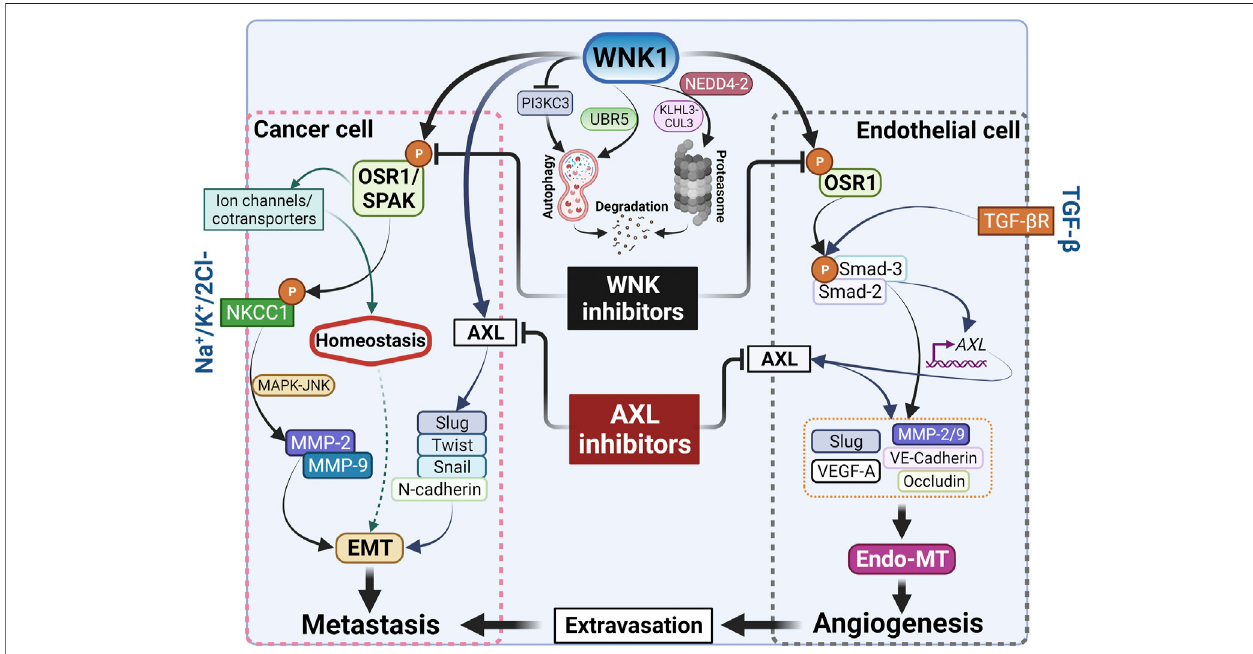
FIGURE 2 | Cancer metastasis and angiogenesis by WNK1. WNK1 is a key in the metastasis cascade via regulation of EMT-effectors and -transcription factors. Created with BioRender.com.